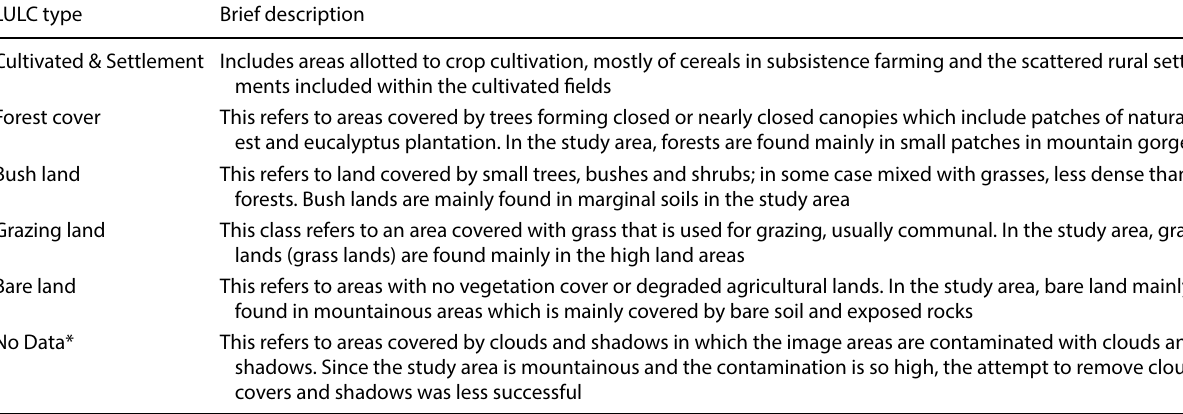
Table 1 LULC Classification Scheme/Description of LULC types in the study area